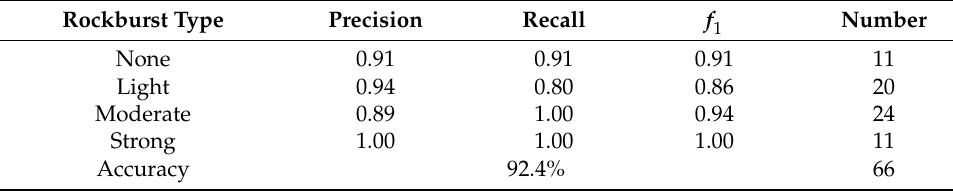
Table 9. The testing performance of DF models with Tr (80%)-Te